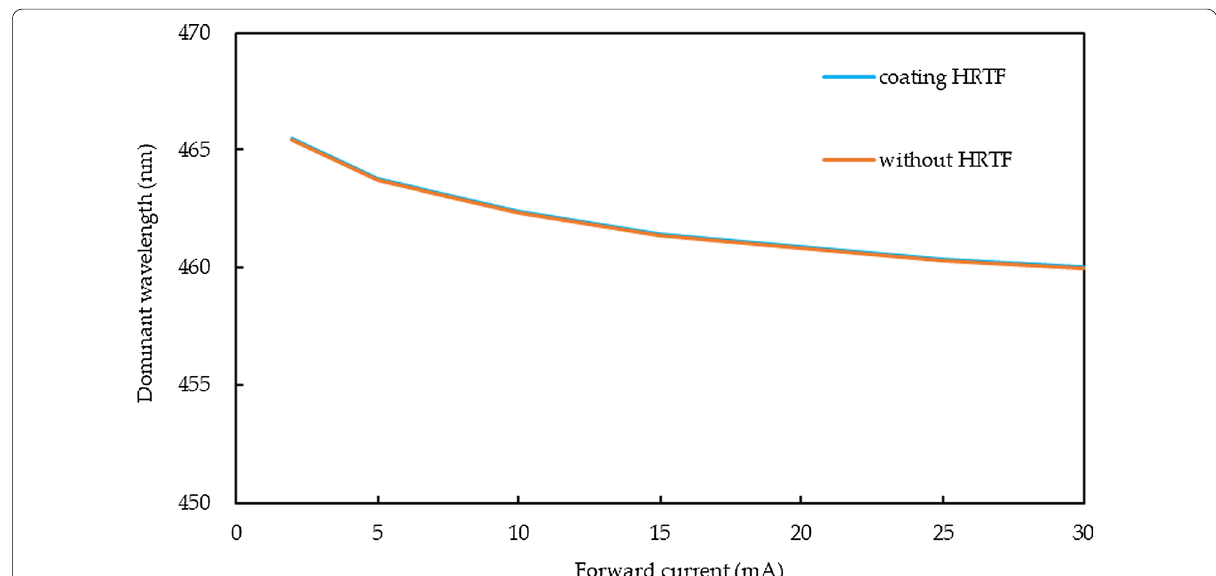
Fig. 10 Changes in the dominant wavelength characteristic curves of micro‑LEDs with and without Al/(HL) 2 film stack coating